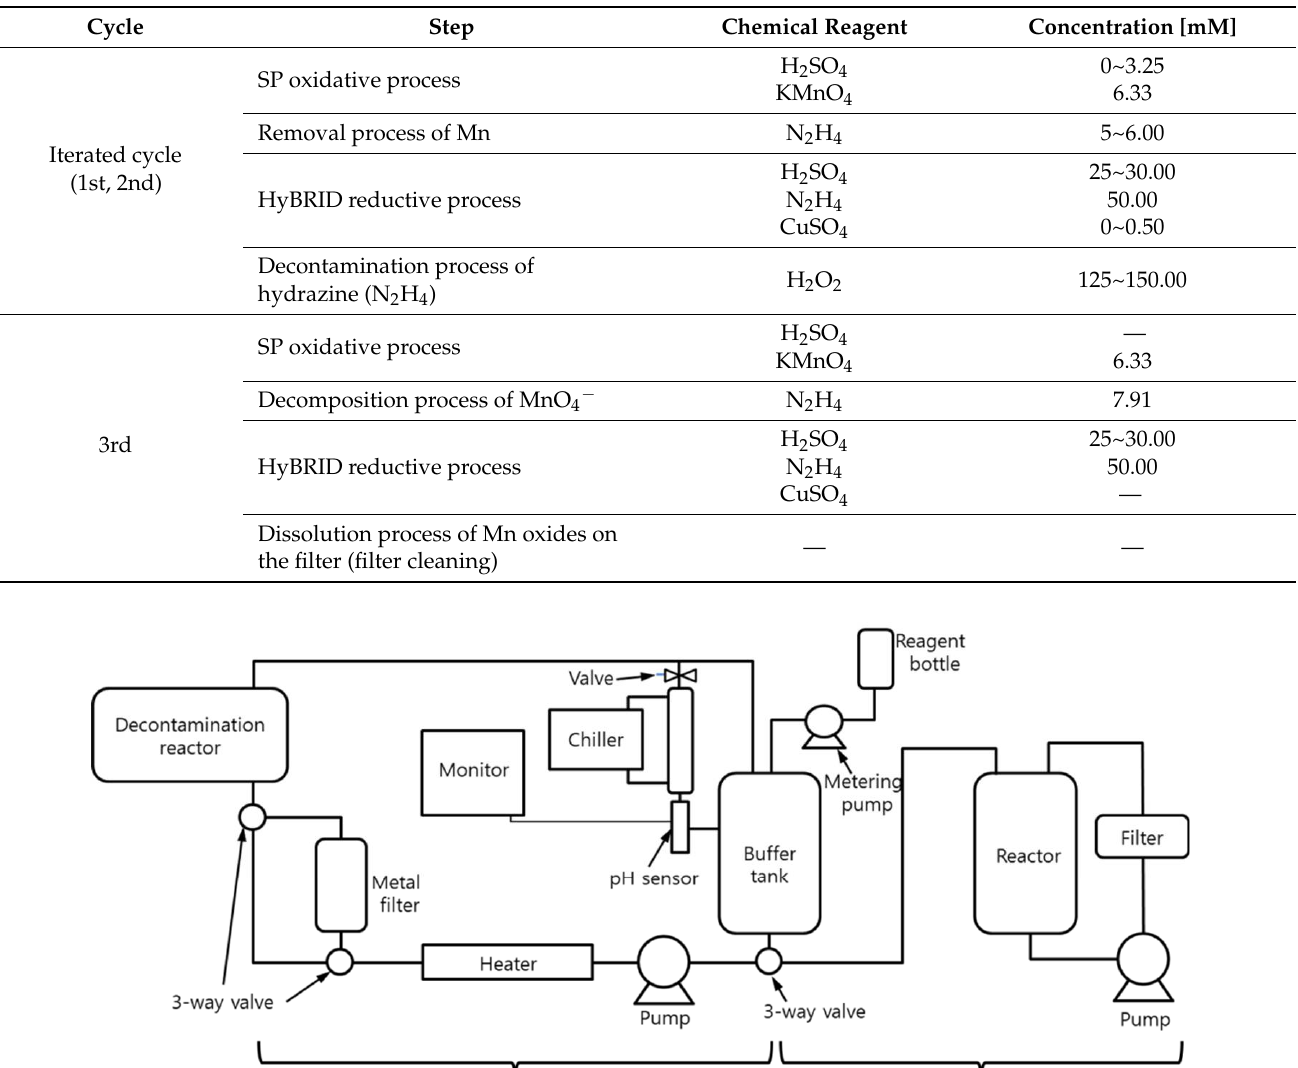
Table 1. Concentrations of chemical reagents used in this study.